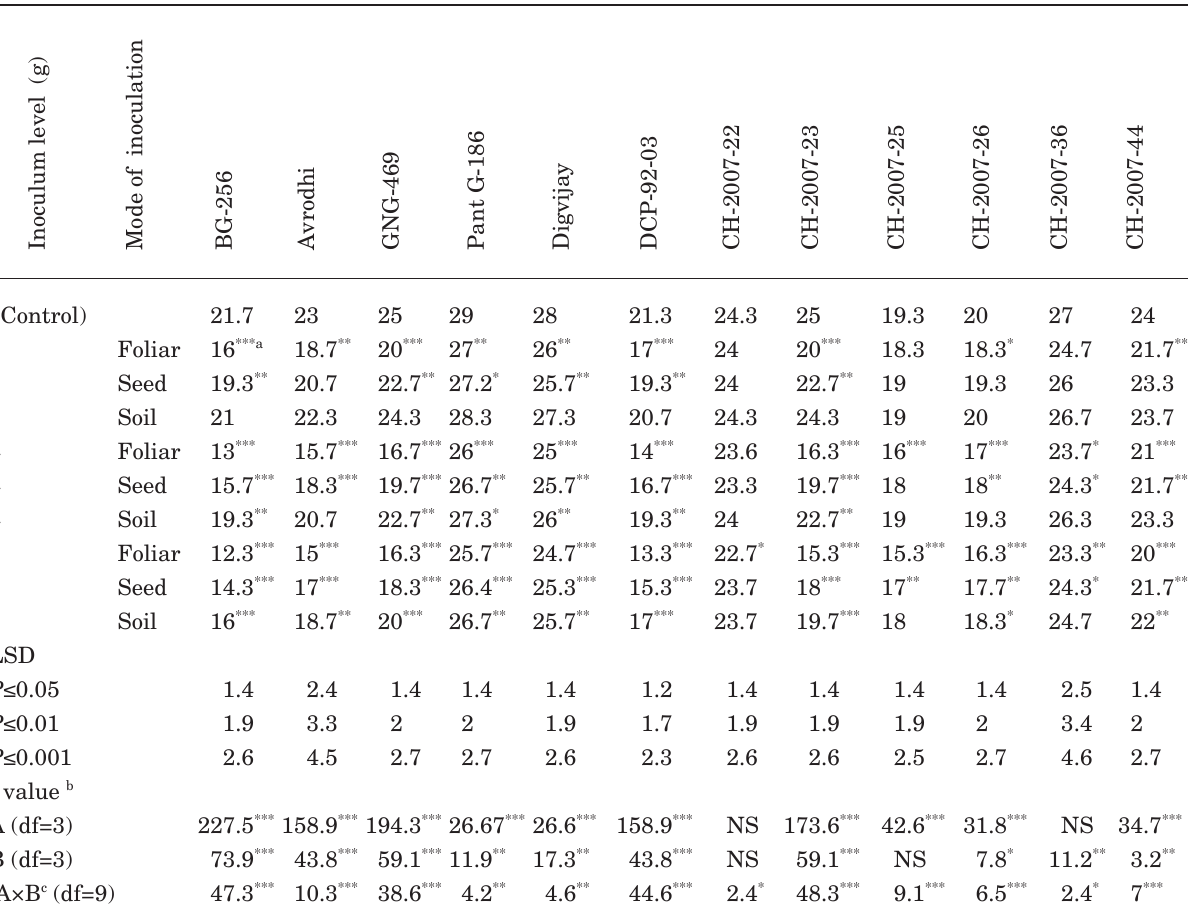
Table 2. Chickpea cultivars receiving foliar, seed and soil inoculation with 2, 4 and 8 g inoculum level of